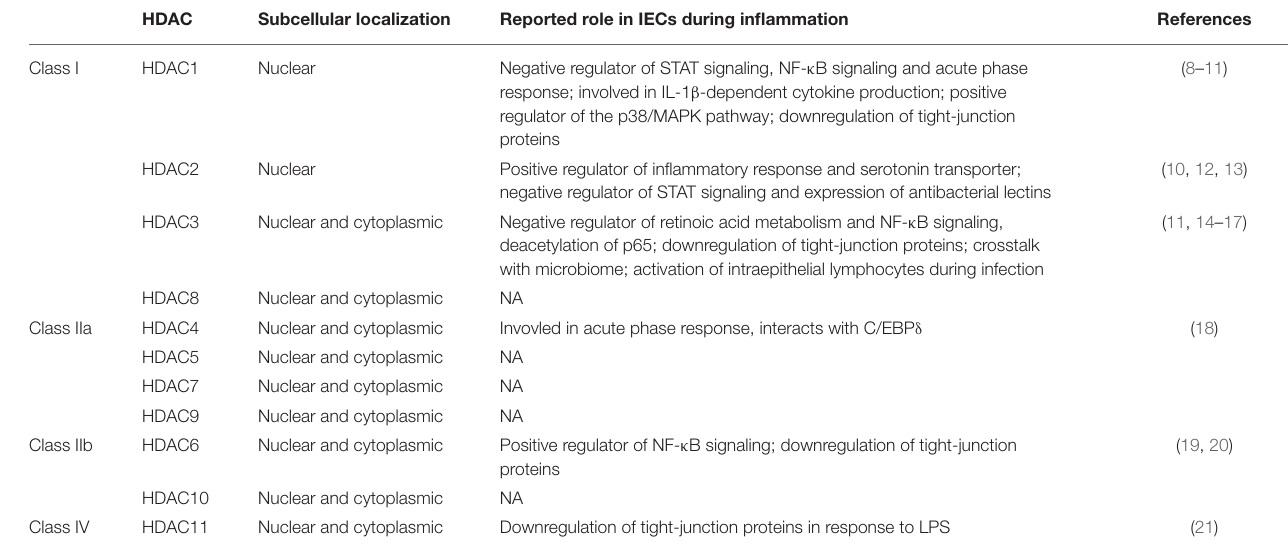
TABLE 1 | Superfamily of Zn2 + -dependent histone deacetylases (HDACs) of the mammalian genome with subcellular localization and reported role in intestinal epithelial cells (IECs) during inflammation. HDAC Subcellular localization Reported role in IECs during